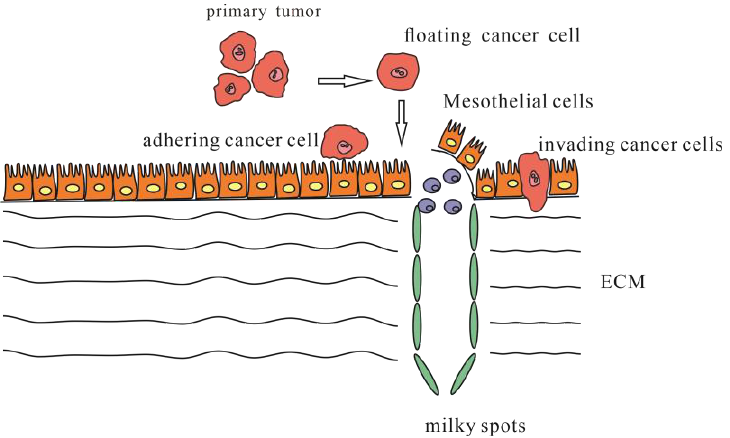
Figure 1. Steps of occurring peritoneal metastasis.